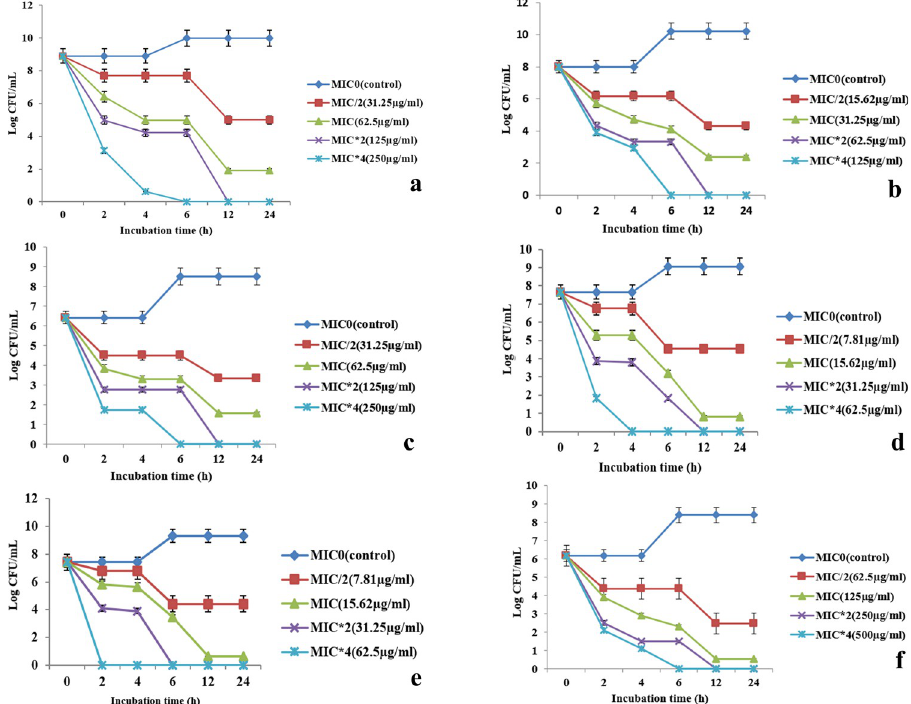
Fig 3. Killing kinetics of pathogenic microorganisms over time when treated with different concentrations of MIC values a– P . aeruginosa b–MRSA c- V . parahaemolyticus d- B . cereus e– B . subtilis f– E . coli . Values on the graphs are the means ± Standard error (SE) of the three